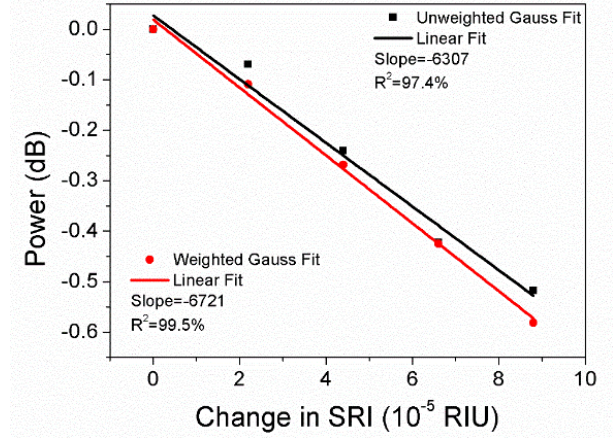
Figure 11. Linear regression of the average cladding mode amplitude obtained by unweighted and weighted Gauss fitting in terms of SRI change 8.8 × 10 − 5 for the wavelength resolution 0.07 nm.